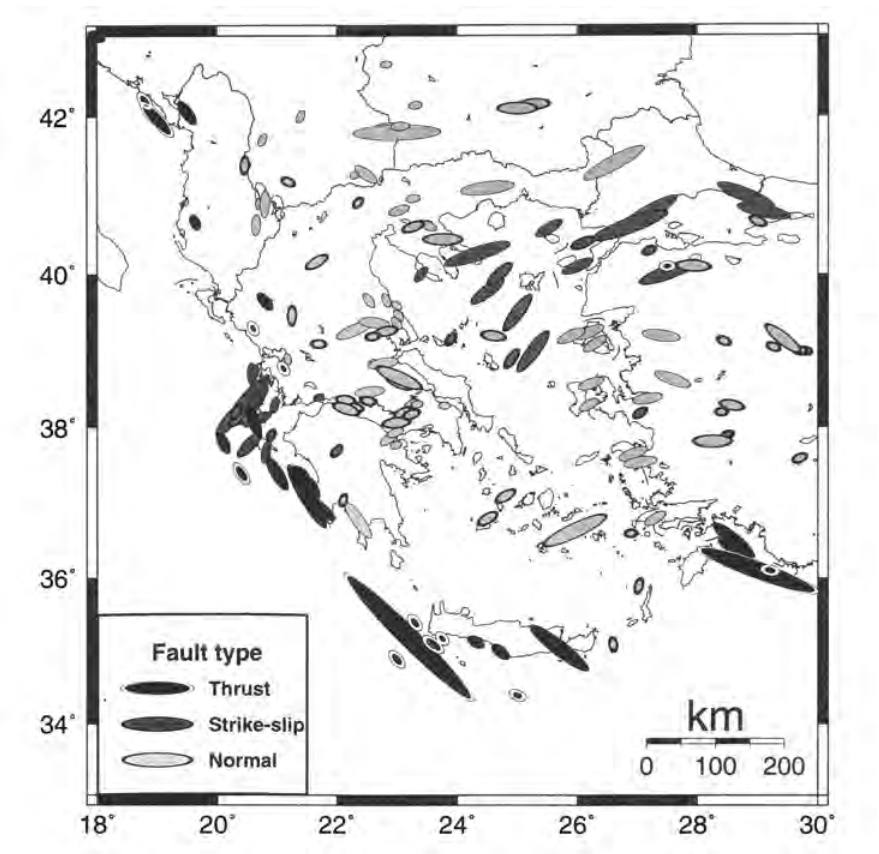
Figure 2. The rupture zones in the area of Greece [after Papazachos et al.